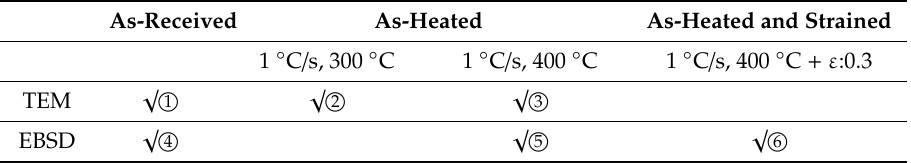
Table 3. Conditions for microstructure observations.